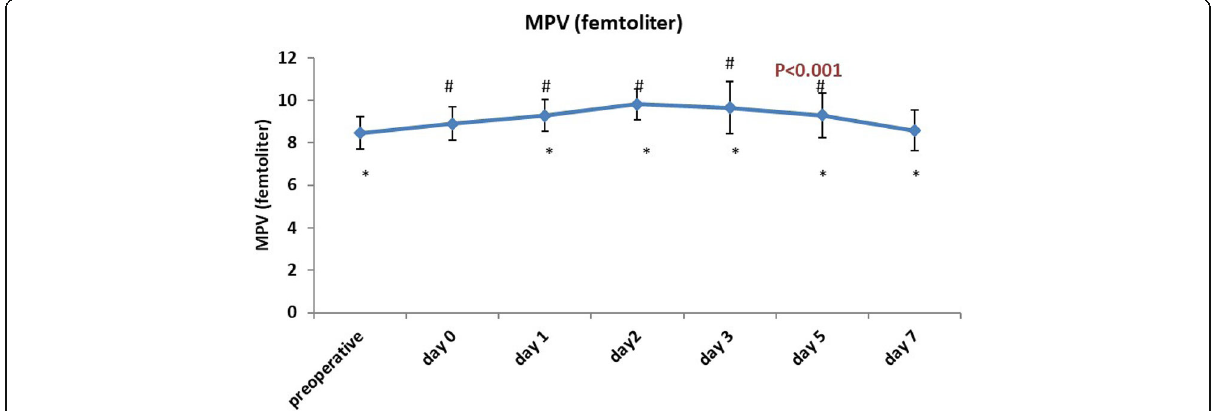
Fig. 2 MPV changes during 1st week of ICU stay. Data presented as means; error bars represent standard deviation. p < 0.001 = highly significant. The number sign (#) indicates highly significant difference compared to preoperative MPV. The asterisk (*) indicates highly significant difference compared to day 0